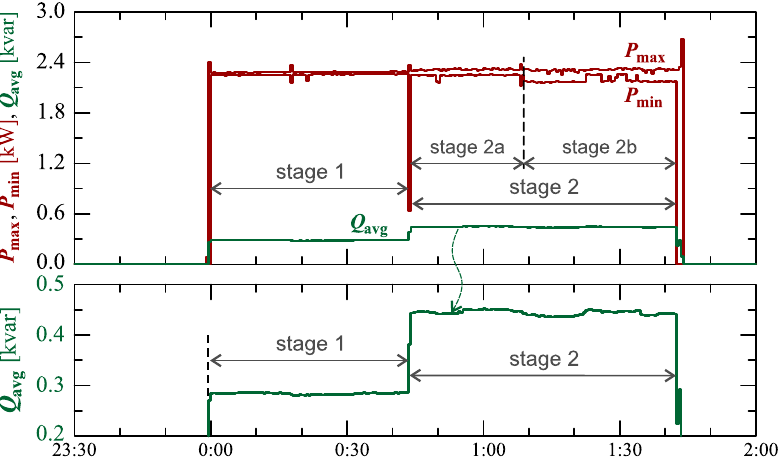
Figure 4. The characteristics of maximum P max = f ( t ) and minimum P min = f ( t ) values of active power and average values of reactive power Q agv = f ( t ) for Case I.